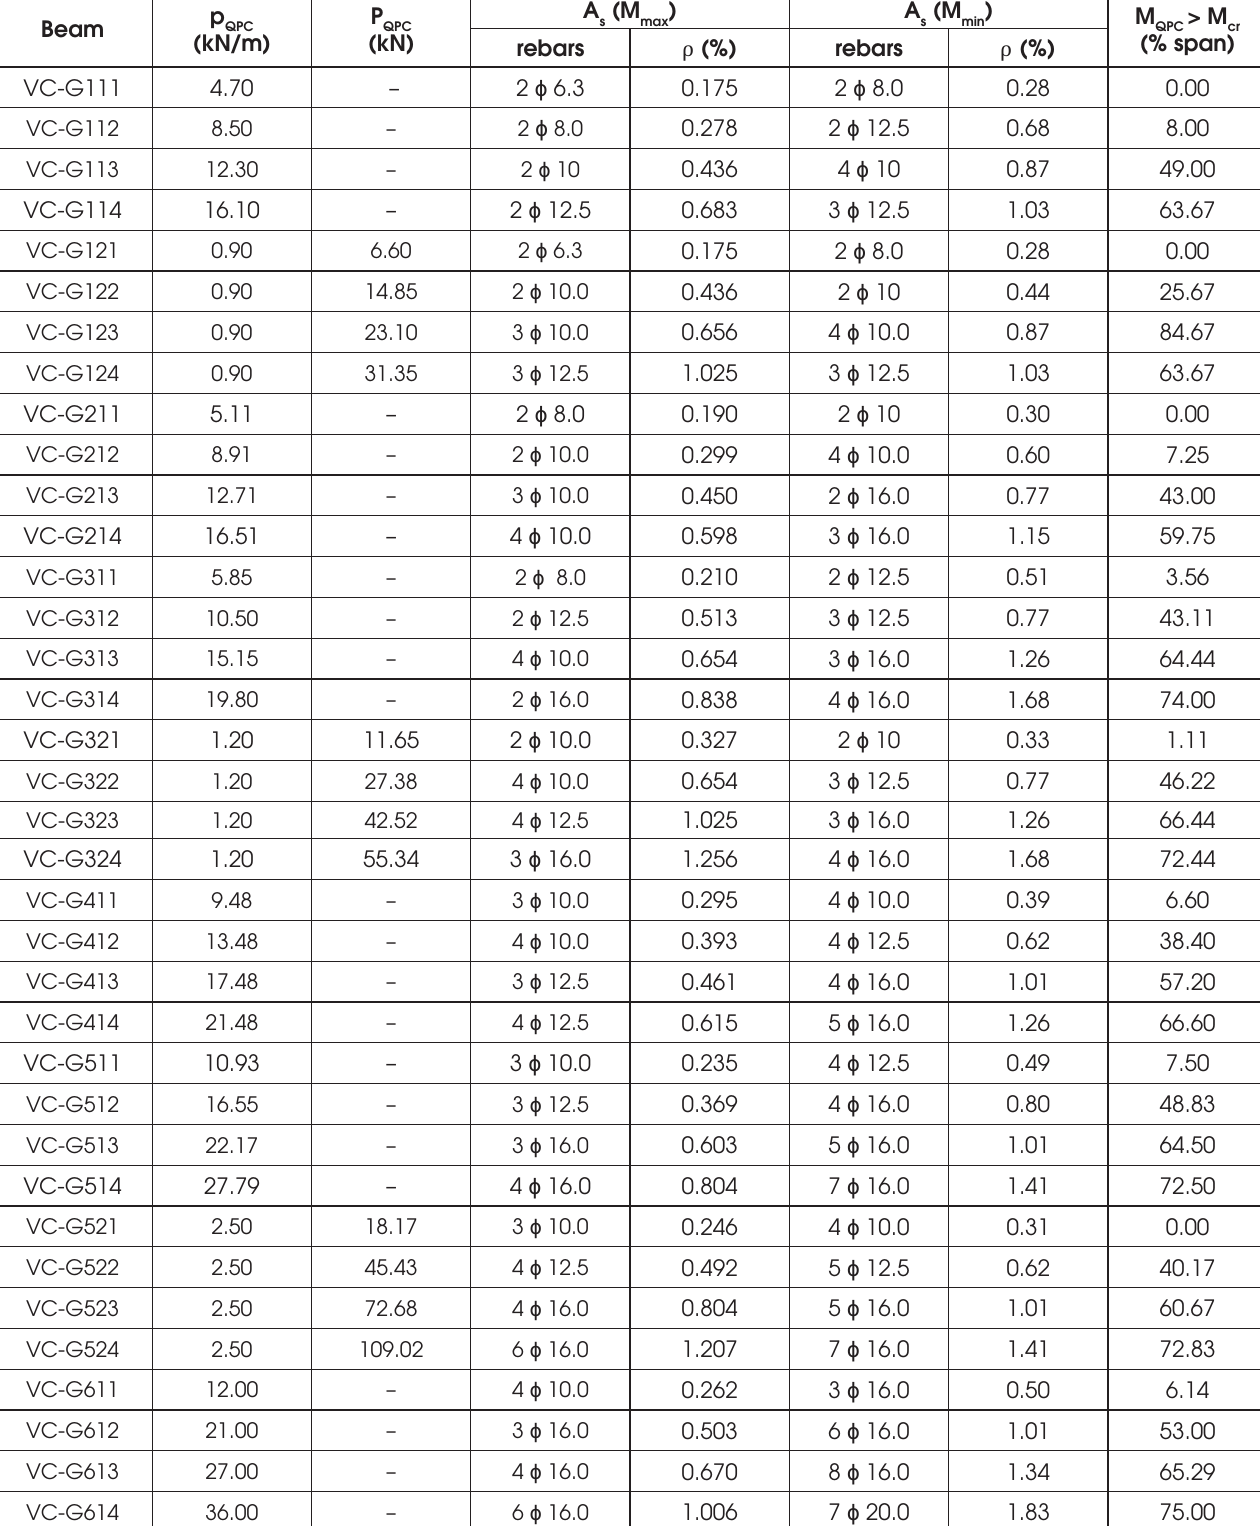
Table 4 Details of load and longitudinal reinforcement for the symmetrical two-span beams